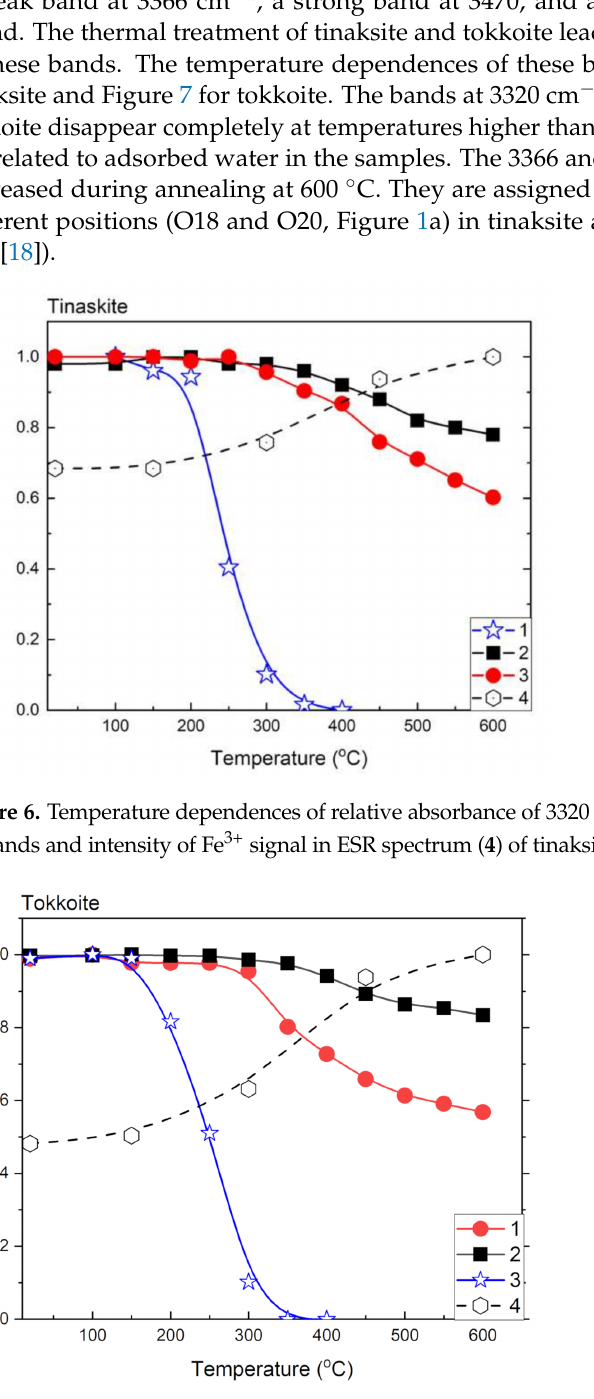
Figure 7. Temperature dependences of relative absorbance of 3360 cm − 1 ( 1 ); 3470 cm − 1 ( 2 ); 3540 cm − 1 ( 3 ) bands and intensity of Fe 3+ signal in ESR spectrum ( 4 ) of